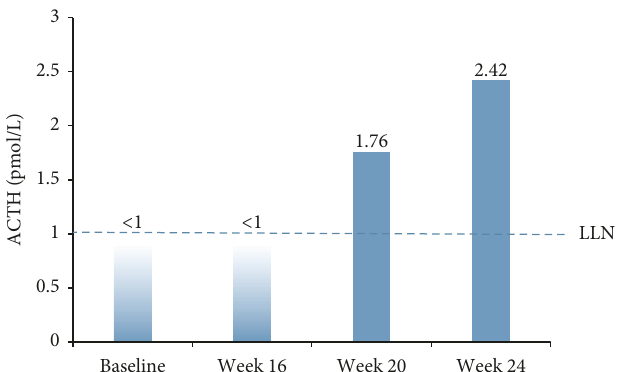
Figure 4: Change in ACTH over time after initiating mifepristone treatment. ACTH, adrenocorticotropic hormone; LLN, lower limit of